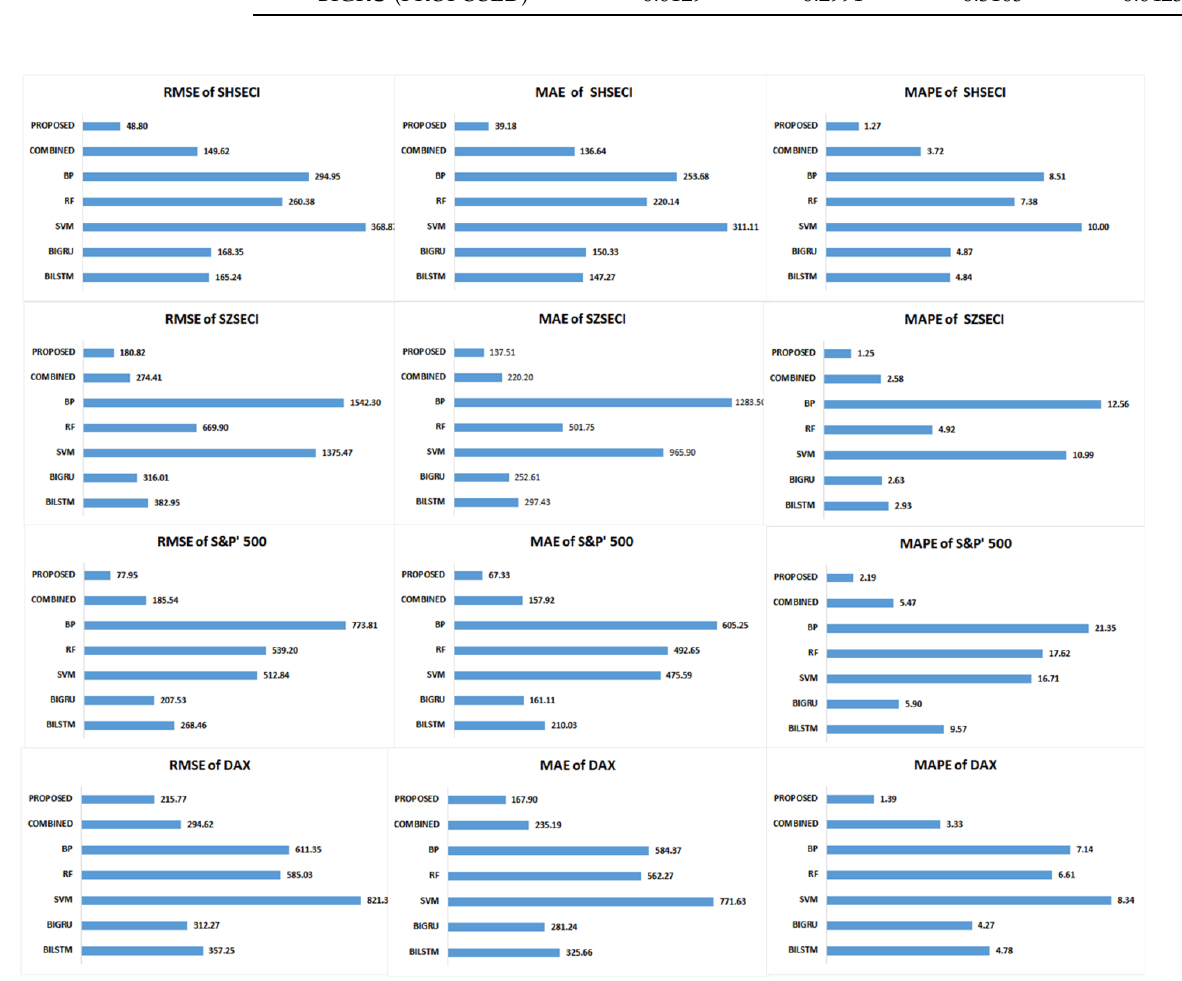
Figure 6 . Prediction performance of 7-day lag experiments. Figure 6. Prediction performance of 7-day lag